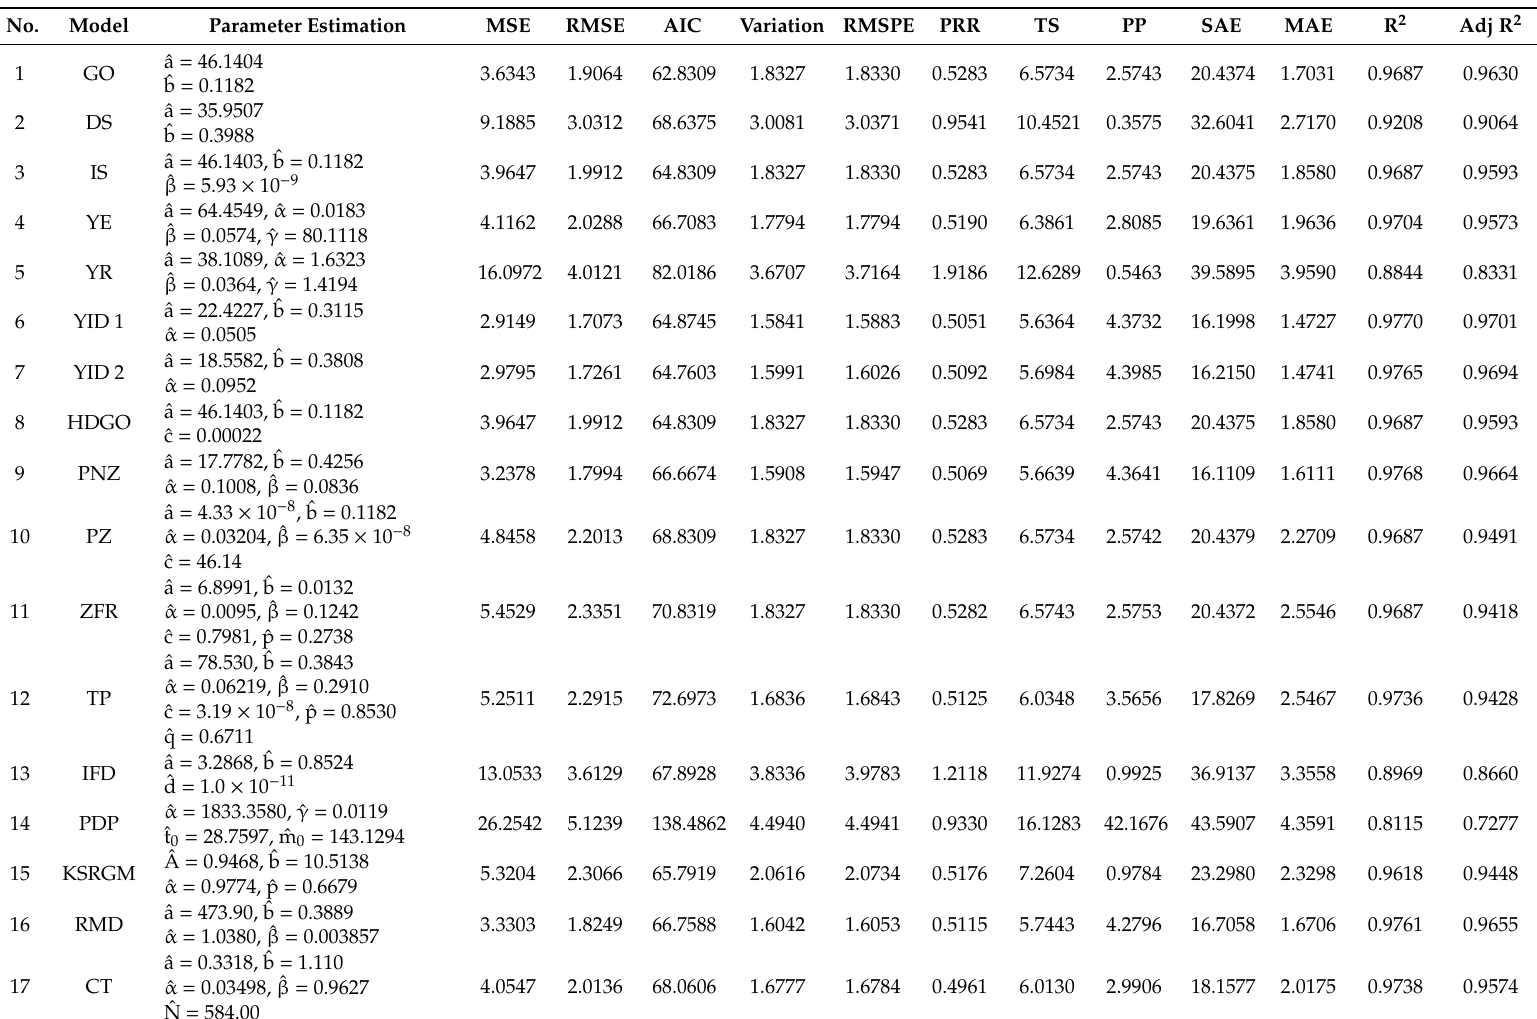
Table 3. Results of model parameter estimation and criteria from dataset